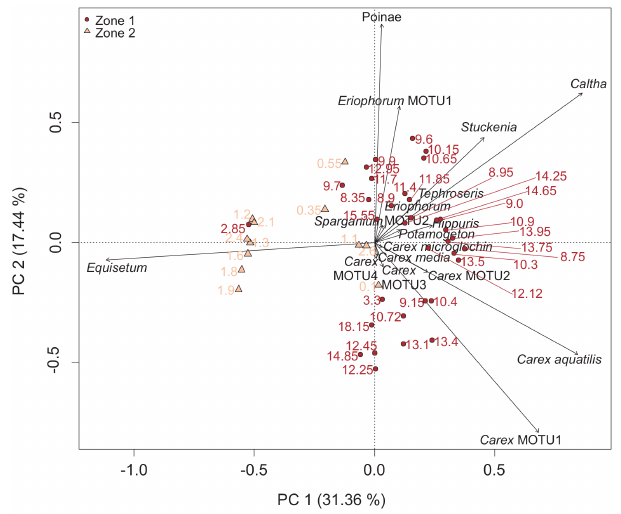
Figure 5. PCA biplot of swamp and aquatic taxa from plant sedaDNA. Sample depths (m) are coloured according to their cor- responding zone. Explained variances of the two principal compo- nents (PC) are shown in